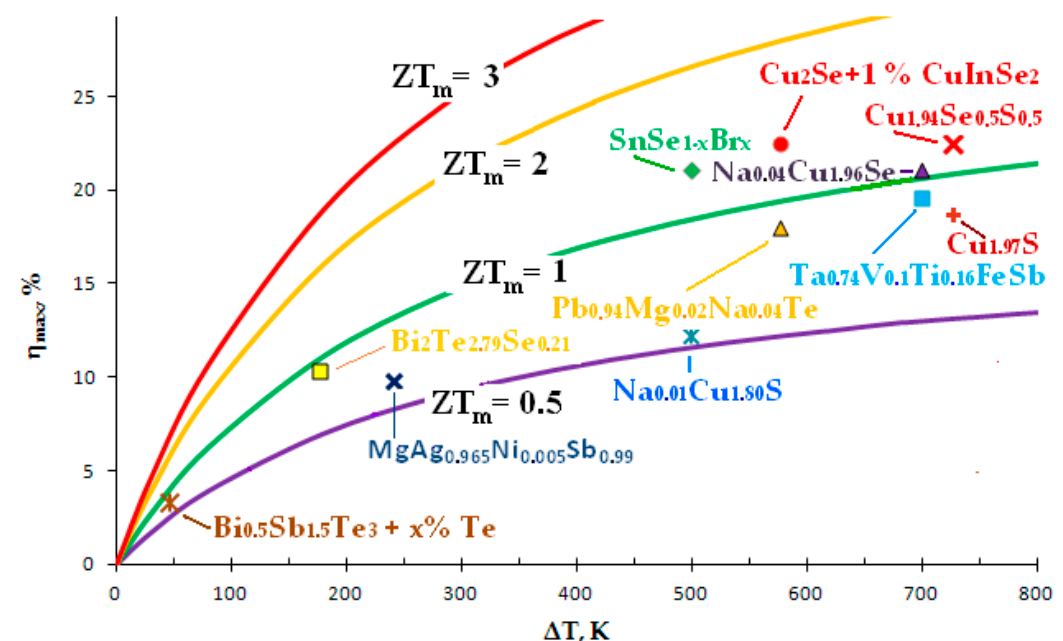
Figure 2. Thermoelectric efficiency of some thermoelectric materials: Cu 1.97 S [84], Na 0.04 Cu 1.96 Se [53], Na 0.01 Cu 1.80 S [31], Cu 2 Se + 1% CuInSe 2 [85], Cu 1.94 Se 0.5 S 0.5 [86], Bi 0.5 Sb 1.5 Te 3 + x% Te [87], Ta 0.74 V 0.1 Ti 0.16 FeSb [88], Pb 0.94 Mg 0.02 Na 0.04 Te [89], MgAg 0.965 Ni 0.005 Sb 0.99 [90], SnSe 1-x Br x [91], Bi 2 Te 2.79 Se 0.21 [92].